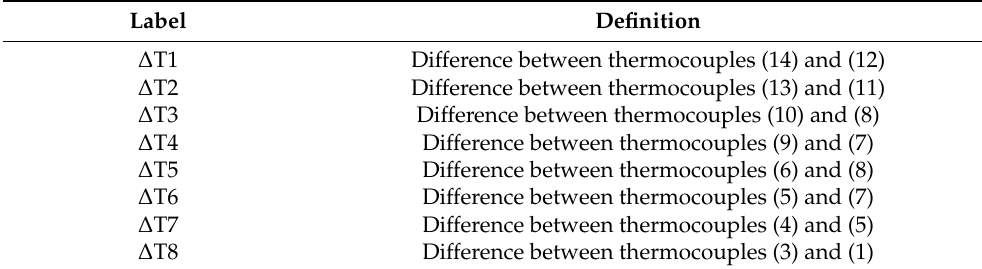
Figure 7. The temperature gradients at different positions. Table 2. Definitions of the labels of the curves in Figure 7.